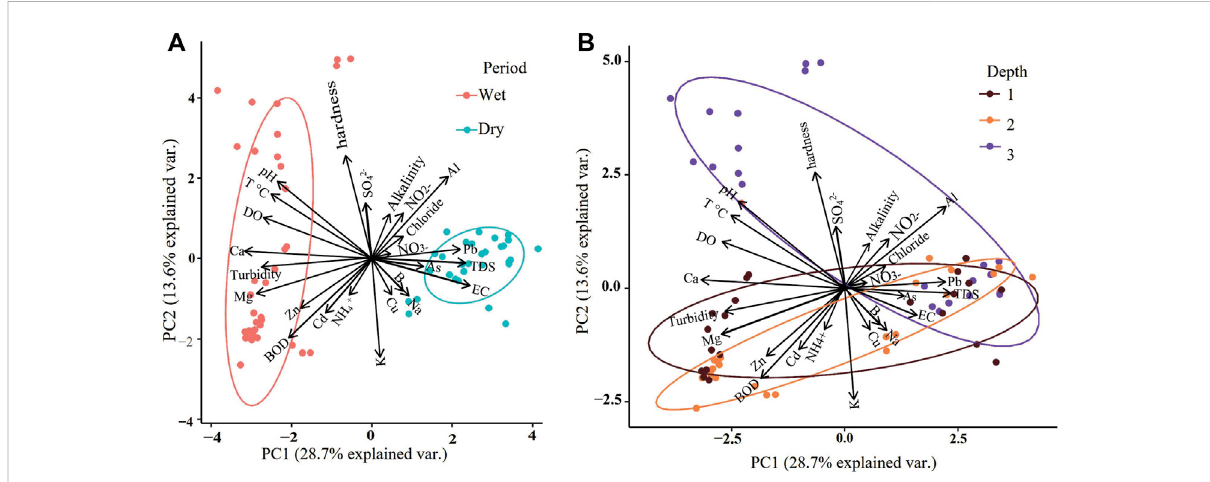
FIGURE 2 Principalcomponentanalysisdescribingtheconcentrationofphysicochemicalparametersandtoxicologicallyimportantelementsbyseasonal period (A) and depth level (B) in Lake Pomacochas. Temperature (T ° C), dissolved oxygen (DO), hydrogen potential (pH), electrical conductivity (EC), biochemicaloxygendemand(BDO),nitrates(NO 3 − ),nitrites(NO 2 − ),totaldissolvedsolids(TDS),ammonium(NH 4 + ),sulfates(SO 4 2- ),chemicaloxygen demand(BOD),magnesium(Mg),aluminum(Al),calcium(Ca),sodium(Na),potassium(K),zinc(Zn),cadmium(Cd),copper(Cu),lead(Pb),boron (B), and arsenic